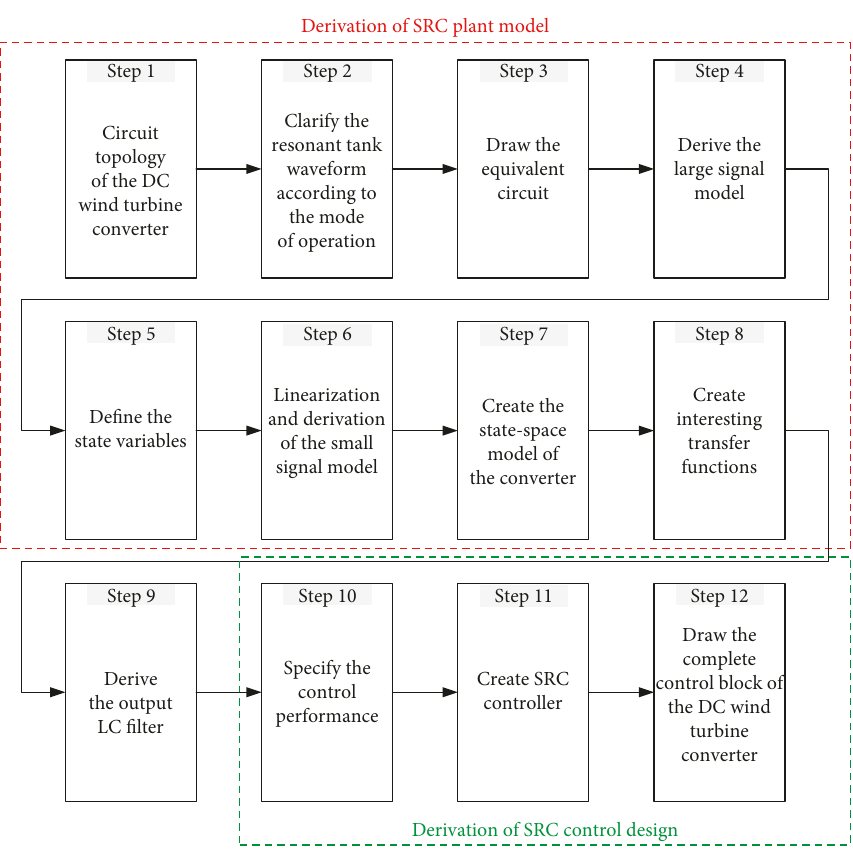
Figure 6: Flow chart of mathematical derivation of the converter plant model and the digital